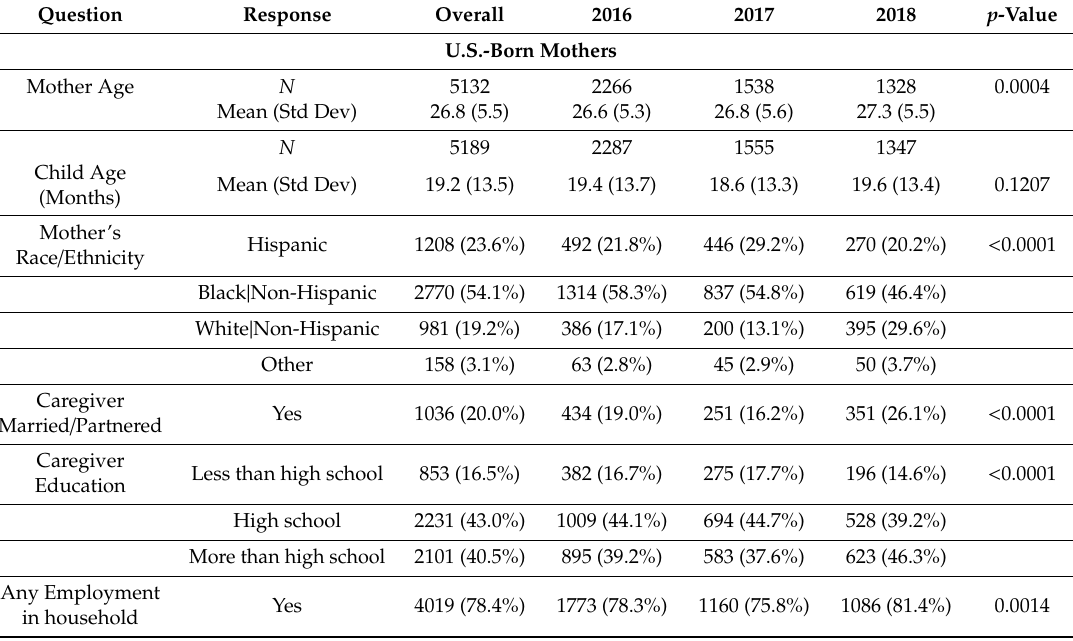
Table 1. Demographics for 2016 to 2018 by mother’s nativity and tenure in the